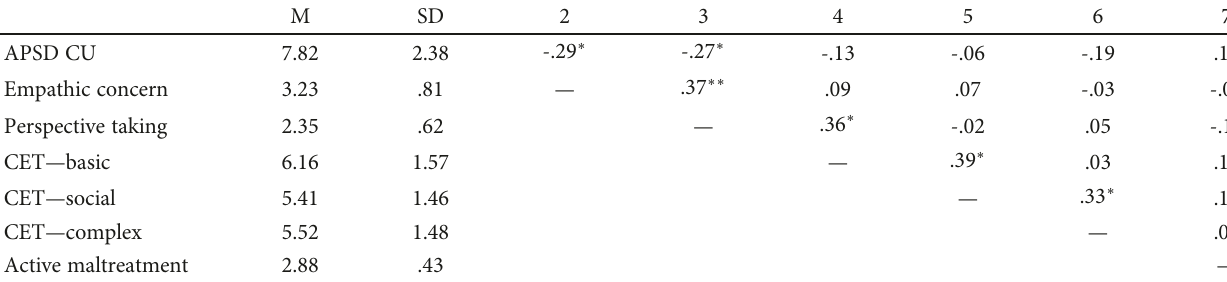
Table 1: Descriptive statistics and correlation matrix.